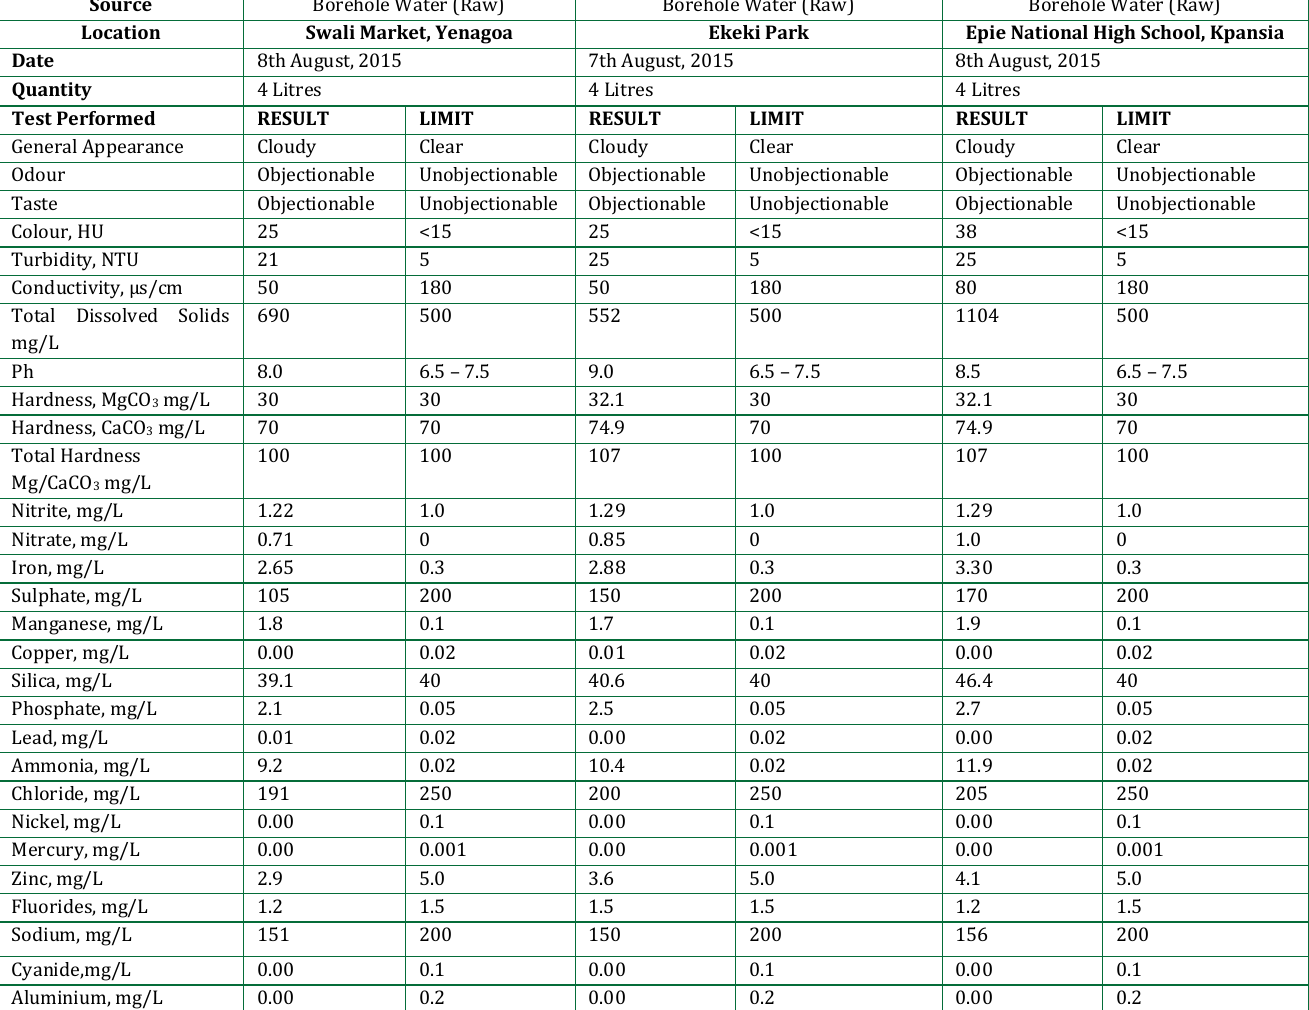
Table 2: Physicochemical Water Sample Analysis Results